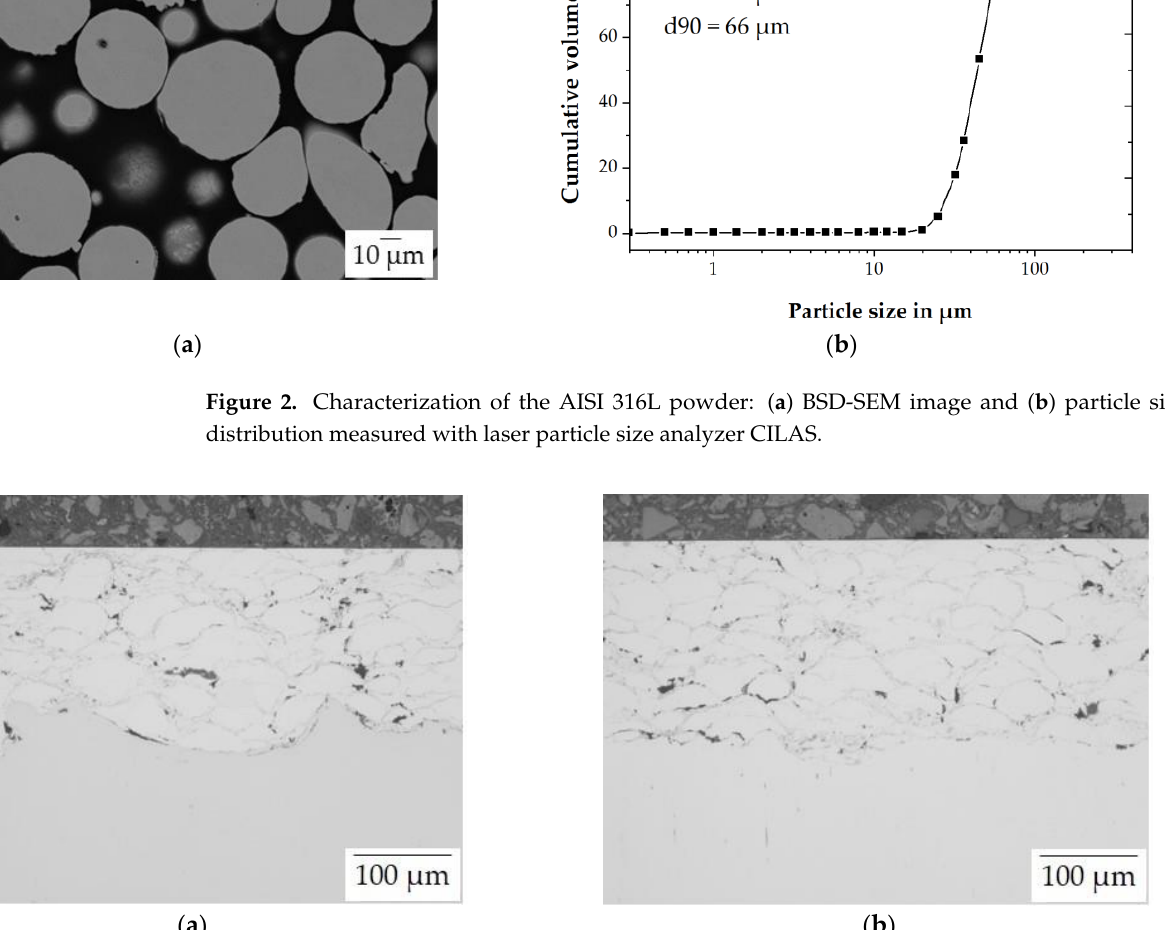
Figure 3. Light microscopic comparison of the AISI 316L coatings deposited by HVAF process on ( a ) mild steel and ( b ) stainless steel in the polished surface finish state before corrosion measurements.